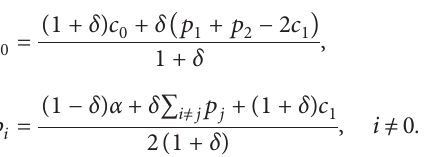
Figure 2: Bifurcation diagram and MLEs for system (11) with respect to parameter k